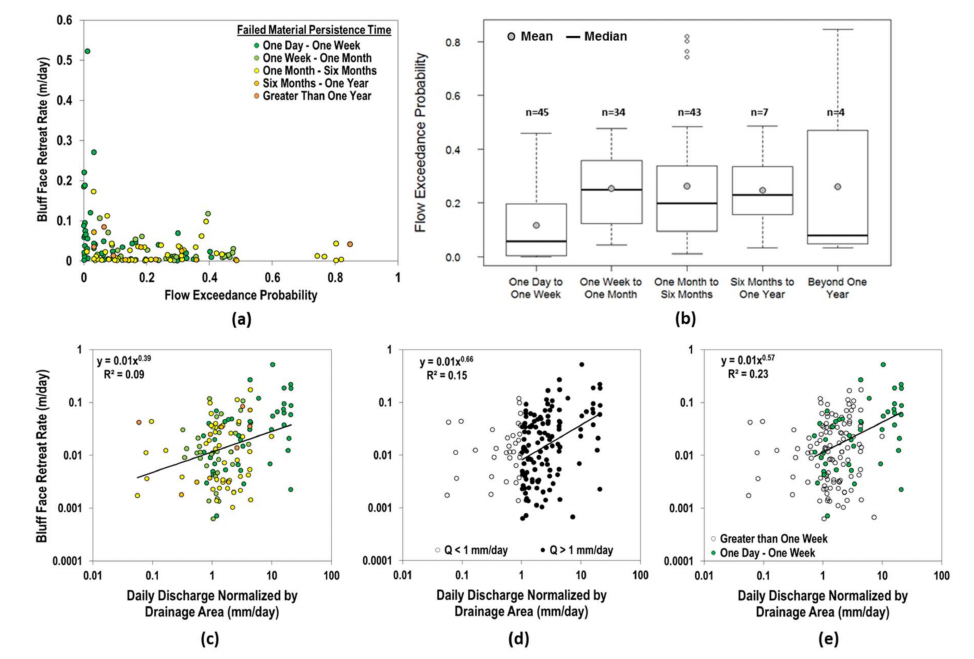
Figure 7. ( a ) Spatially averaged event retreat rate (m/day) from time lapse photo estimated erosion versus the failure date flow exceedance probability. Points are color-coded by the persistence time of the failed till material; ( b ) box-and-whisker (25% and 75%) plots of flow exceedance probabilities associated with categorical failed till persistence times. Black bar and grey circle indicate median and mean descriptive statistics, respectively, and n indicates the number of observations in each category; ( c ) till event retreat rate versus daily discharge normalized by drainage area upstream of gauge. Line indicates a weak power law relation between event size and discharge; ( d ) same as ( c ), but regression applied only to events when daily discharge was greater than 1 mm/day; ( e ) same as ( c ), but regression applied only to events that persisted for less than one